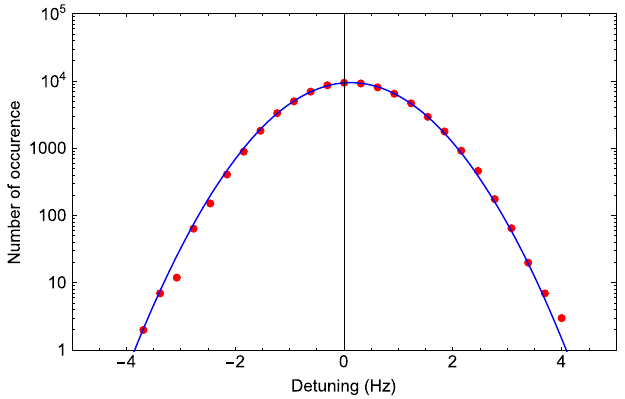
FIG. 13. An example of microphonics detuning probability. Gaussian fitting is included ( σ